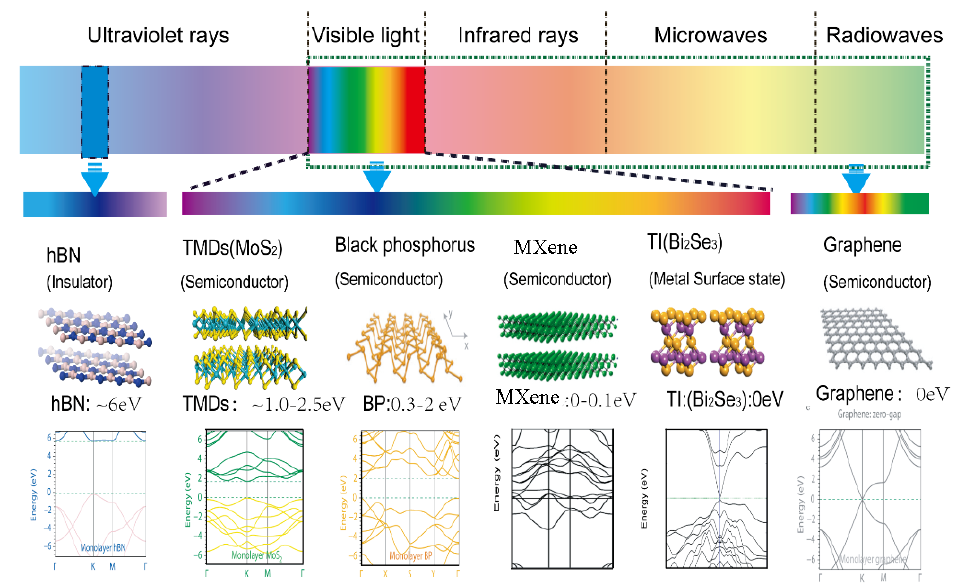
Figure 1. Typical two-dimensional materials: Spectral properties, atomic structures and band diagrams of hBN, TMD, BP, Mxene, TI and graphene.